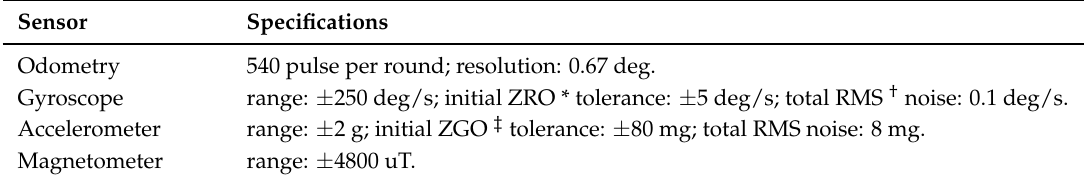
Table 2. Specifications of sensors.